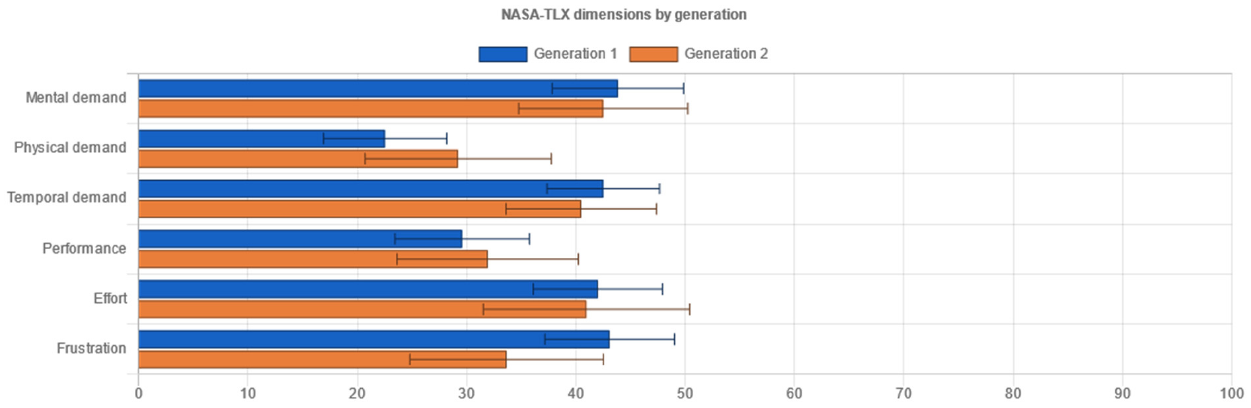
Figure 16. NASA-TLX dimensions by generation.